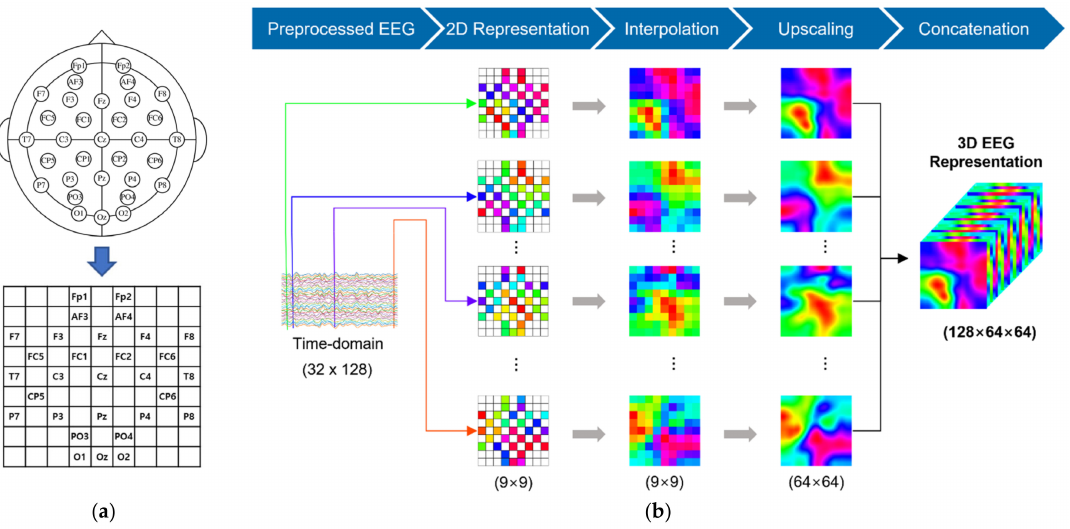
Figure 2. ( a ) 2D representation of 32 channels according to the international 10–20 system. The names of the electrodes are annotated in the 2D map. The EEG signals at a time point from all EEG channels are transformed into a 2D map (9 × 9 matrix) according to the positions of electrodes on the brain. ( b ) The process of 3D map representation of EEG signals. The 3D EEG spatiotemporal representation serves as the input of the proposed CNN-BN